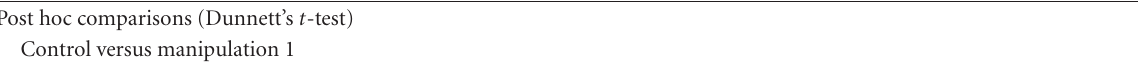
Post hoc comparisons (Dunnett’s t -test) Control versus manipulation 1 Control versus manipulation 2